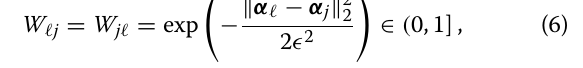
we obtain an undirected graph. A part of an exemplary graph is illustrated in Fig. 3. The edge which connects nodes ¯ α (cid:2) and ¯ α j has weight W (cid:2) j = W j (cid:2) and should